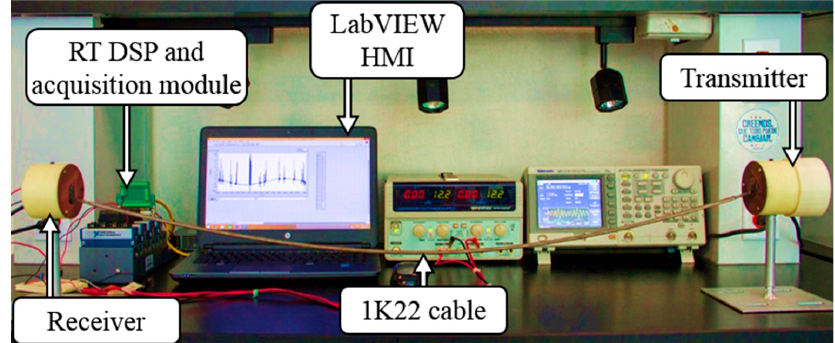
Figure 11. Experimental setup.